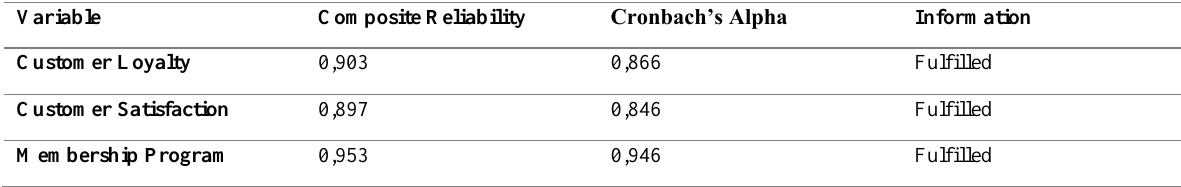
Table 3: Construct Reability